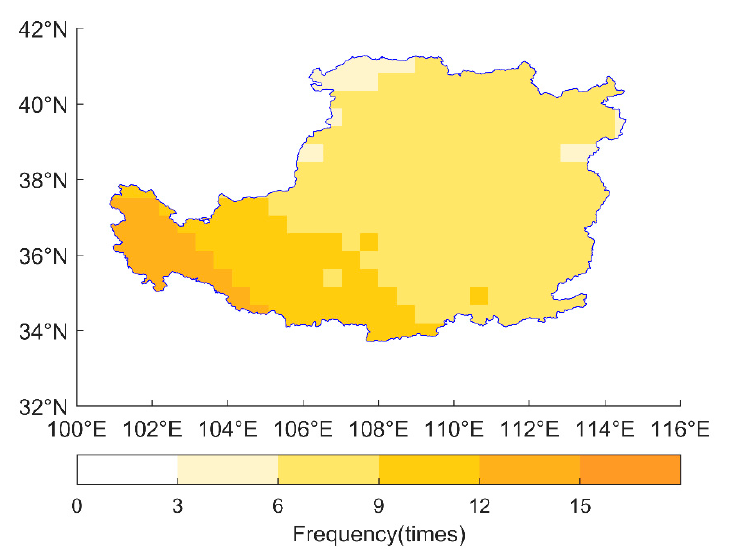
Figure 4. Spatial distribution of the average annual extreme precipitation events frequencies in the Loess Plateau for the 1.5 °C global warming scenario.